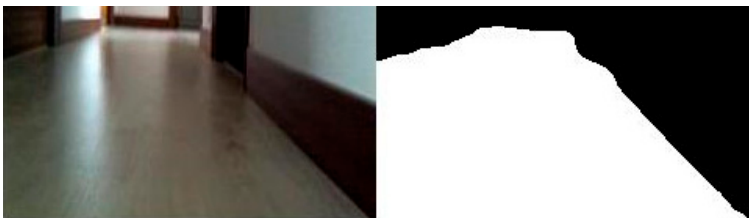
Figure 6. The results of semantic segmentation, in which the left side image is the original, and the right side is the ResNet-18 estimated mask.